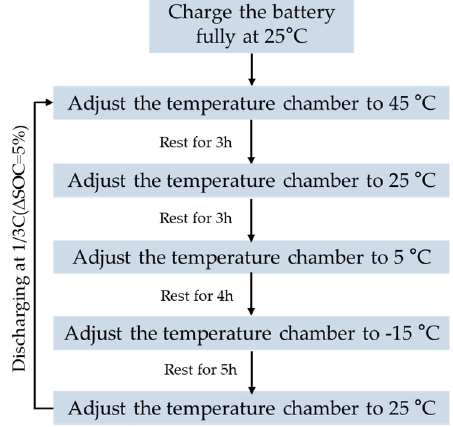
Figure 4. Variable temperature OCV experimental flowchart.